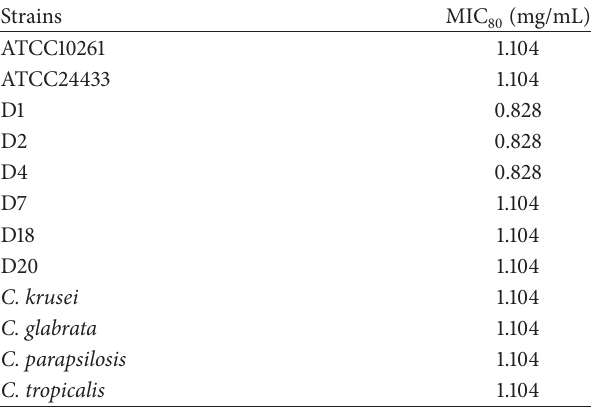
Table 1: MIC of C. albicans and non- albicans species in presence 80 of